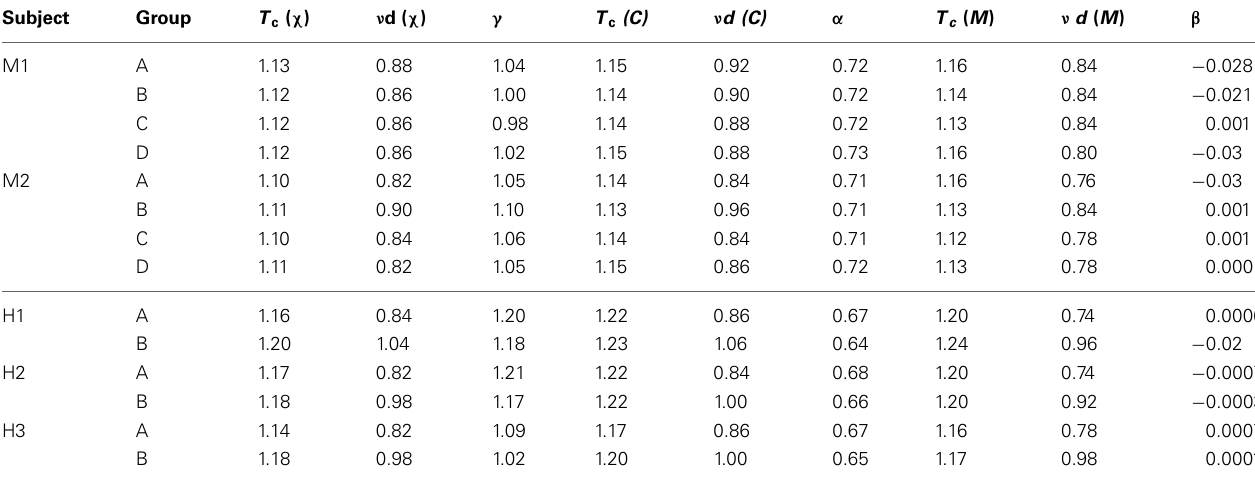
Table 1 | Critical temperature T c and critical exponents ν d , α , β , and γ estimated using finite size scaling analysis (FSS) for eight 20-eletrode sub-groups in two monkeys (M1, M2) and six 20-sensor sub-groups in three human subjects (H1–H3).